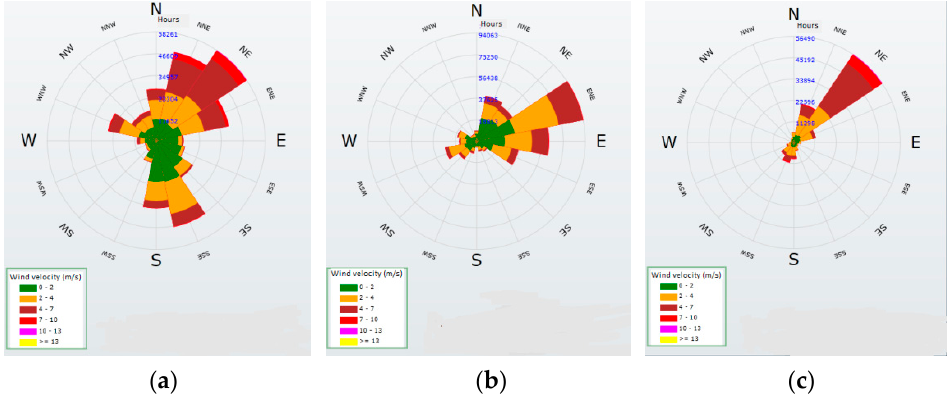
Figure 2. Wind rose based on hourly wind measurements for 1970–2016: ( a ) Ayvalık Meteorological Station; ( b ) Edremit Meteorological Station; and (c) wind rose based on wind predictions with 6 h intervals for 2000–2016 from European Centre for Medium Range Weather Forecast (ECMWF) operational archive for coordinates of 39.50 °N–26.90 °E [33].